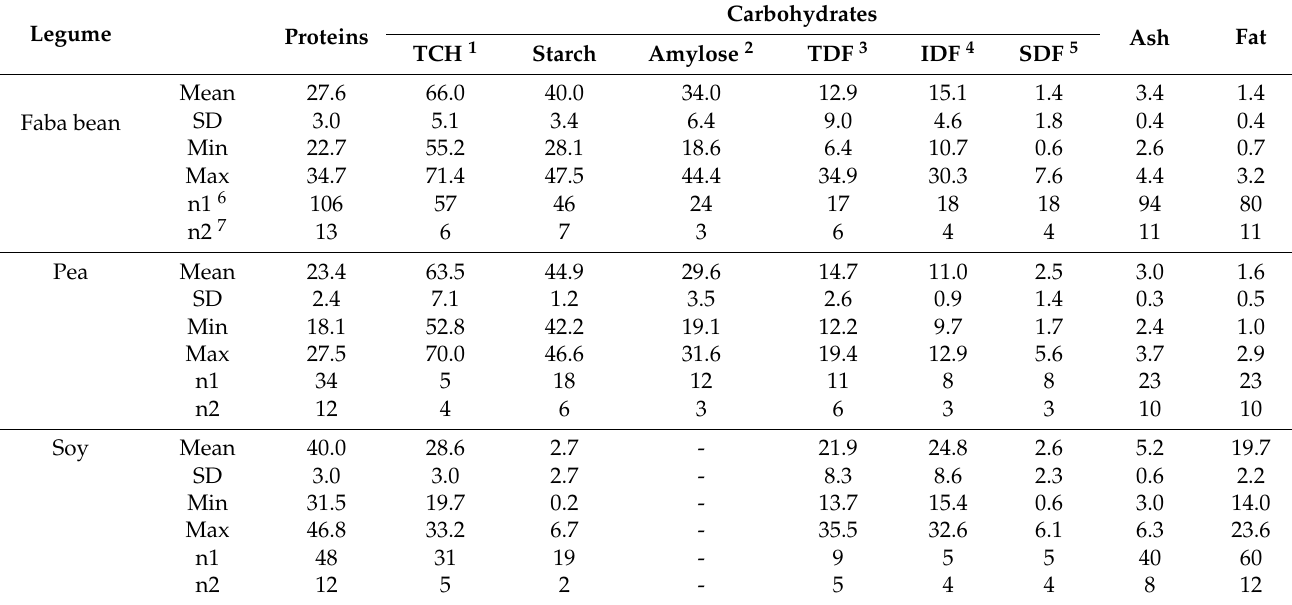
Table 1. Proximate compositions of the faba bean compared to pea and soy (g/100 g dry base) compiled from various studies